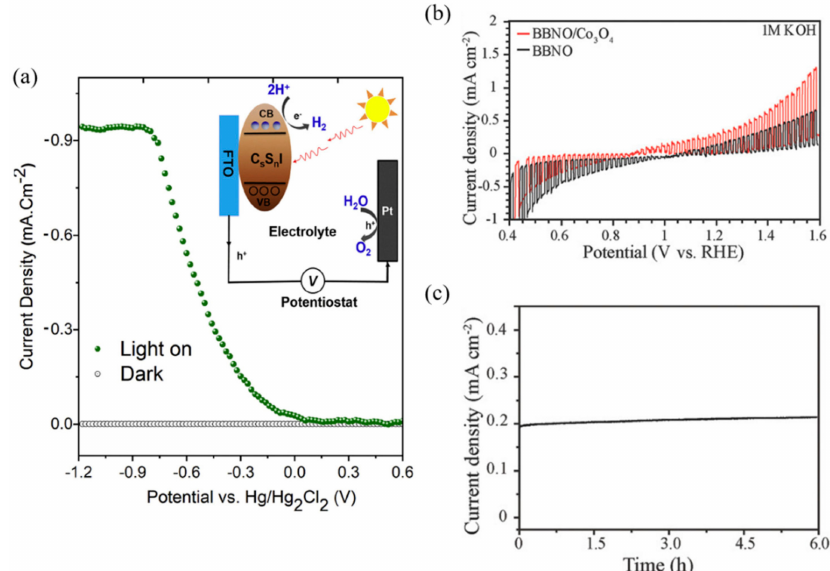
Figure 12. Cases of improving stability by using inorganic perovskites. ( a ) The photocurrent density curve of the Cs 2 SnI 6 compound using a three-electrode system with a 0.3 M NaCl electrolyte and the inserted picture shows the working principle of the system. ( b ) PEC water splitting performance of a Ba 2 Bi 1.4 Nb 0.6 O 6 photoanode. LSV curves of PEC water oxidation in 1 m KOH solution